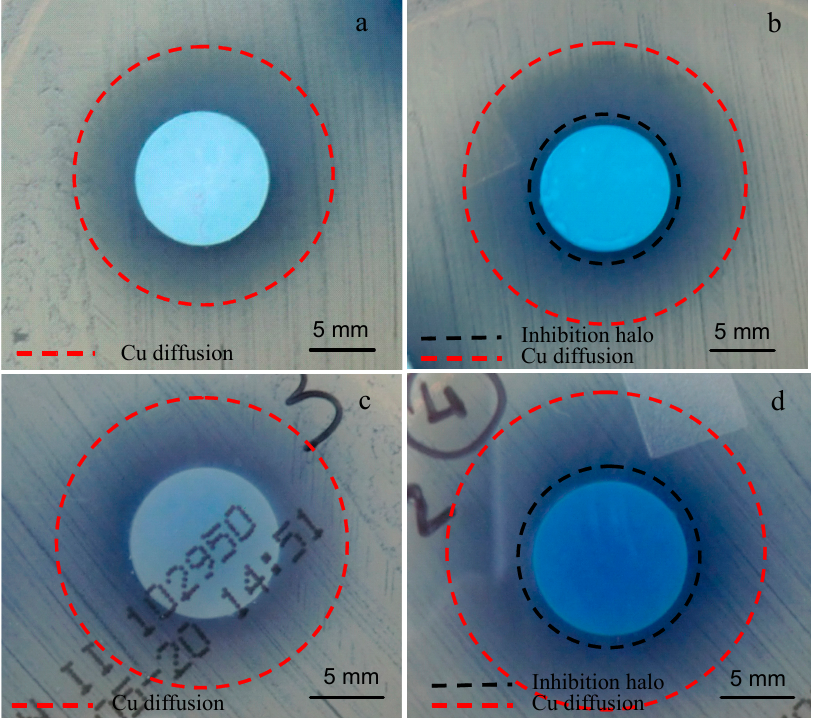
Figure 11. Inhibition halo test of ( a , c ) SBA3-Cu0.01; and ( b , d ) SBA3-Cu0.05; towards S. aureus strain, ( a , b ) front; and ( c , d ) back of the plate.